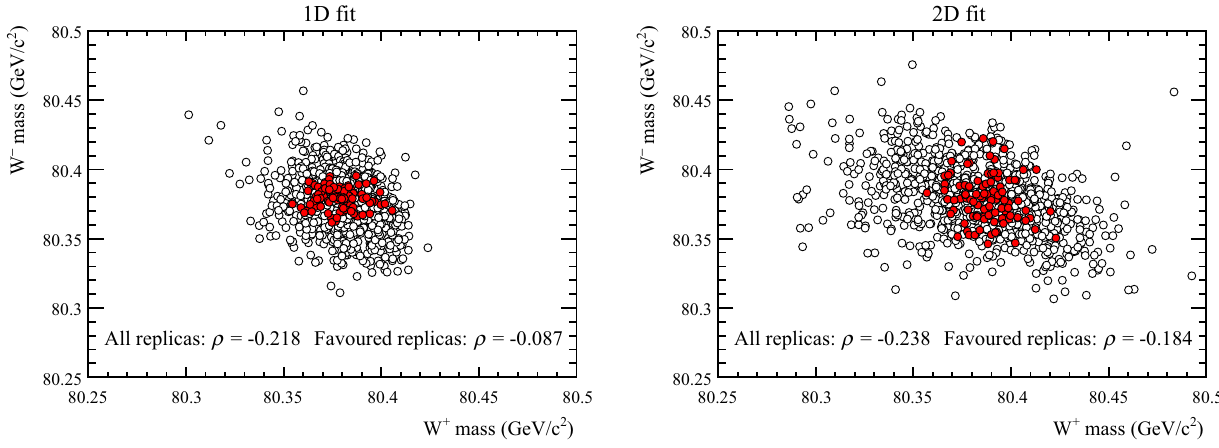
Fig. 11 The distribution of the W − versus W + mass determined from a single toy dataset with each of the NNPDF3.1 replicas. Ten percent of the replicas with the highest P (χ 2 ) (product over the two W charges) are assigned red